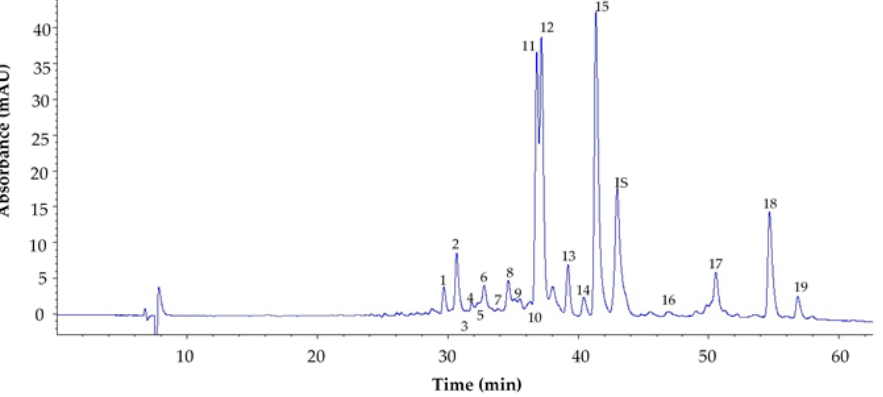
Figure 1. HPLC-DAD profile of carotenoids in mature grapes (Primitivo cv ). Peaks: (1) violaxanthin-like structure; (2) violaxanthin; (3) (8’R)-neochrome; (4) (9’ Z )-neoxanthin; (5) (8’S)-neochrome; (6) 5,6-